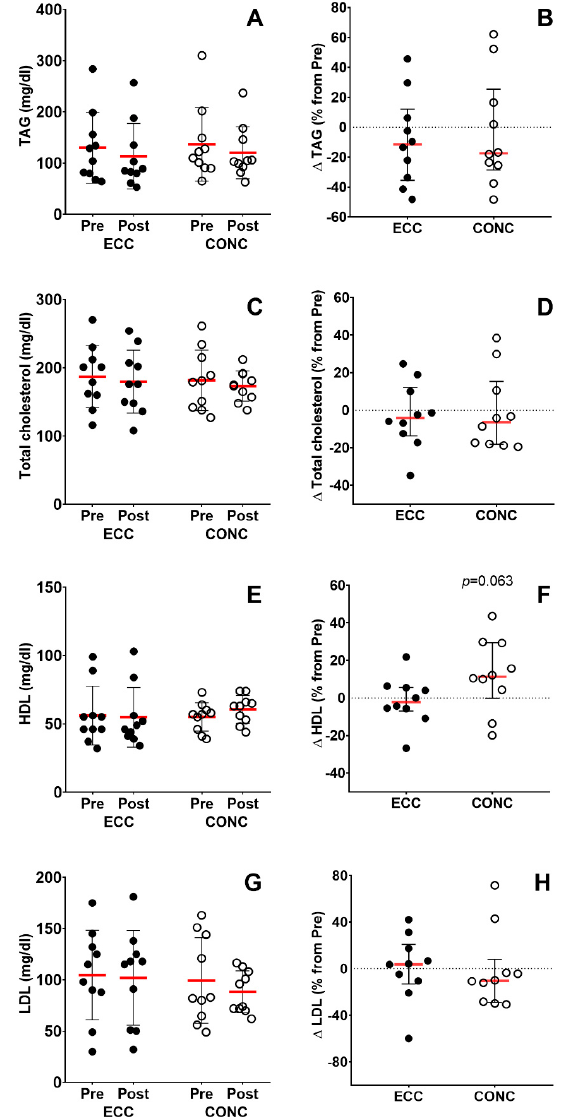
Figure 6. Lipid profile. Triglycerides (TAG) levels in absolute values ( A ) as a percentage of change from pre-training values ( B ). Total cholesterol levels in absolute values ( C ) as a percentage of change from pre-training values ( D ). High-density lipoprotein cholesterol (HDL) levels in absolute values ( E ) as a percentage of change from pre-training values ( F ). Low-density lipoprotein cholesterol (LDL) levels in absolute values ( G ) as a percentage of change from pre-training values ( H ). ECC: eccentric cycling, CONC: concentric